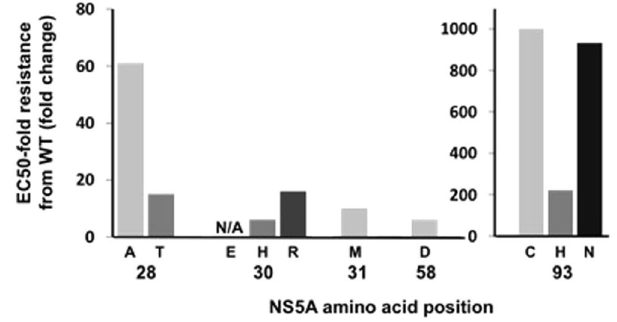
Figure 2. Impact of the NS5A substitution variants according to the fold change. Abbreviations: WT, wild type; EC50, concentration required to achieve 50% inhibition of HCV replication; NS5A, nonstructural protein 5